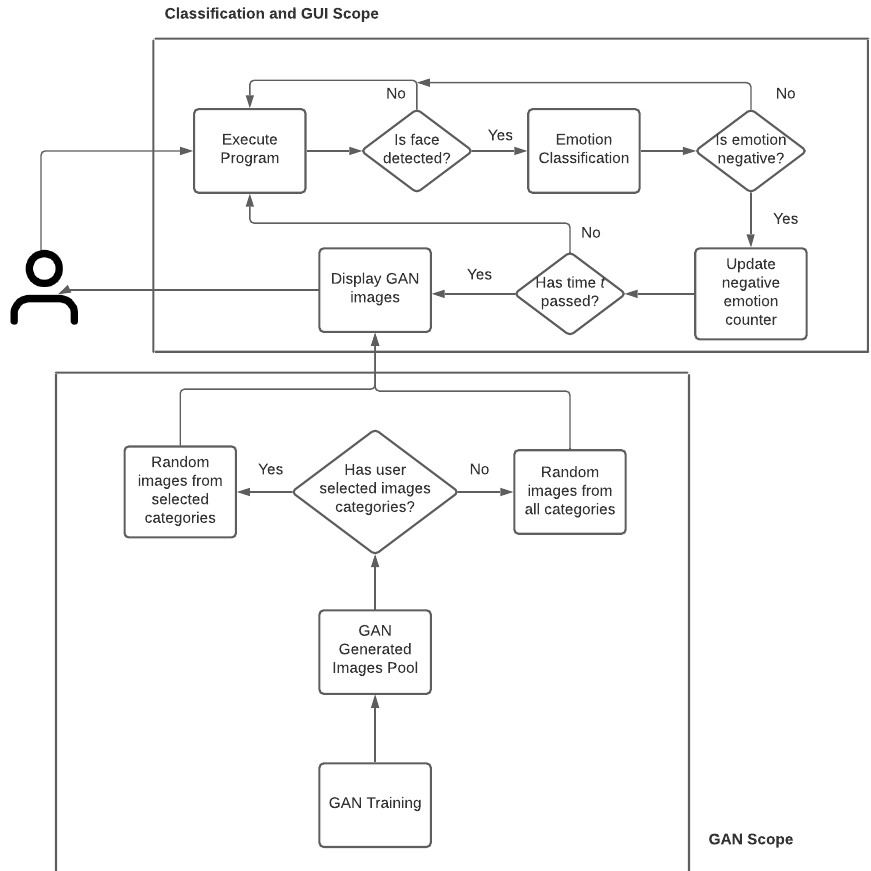
Figure 1. System architecture.